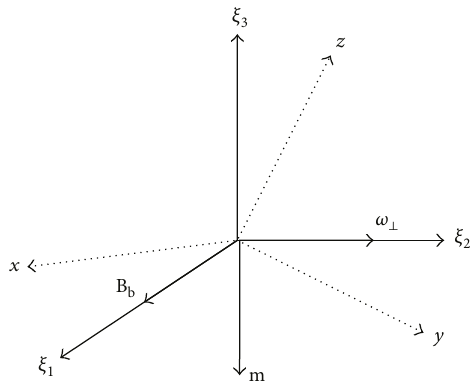
Figure 2: Auxiliary frame (solid line) and body reference frame (dotted